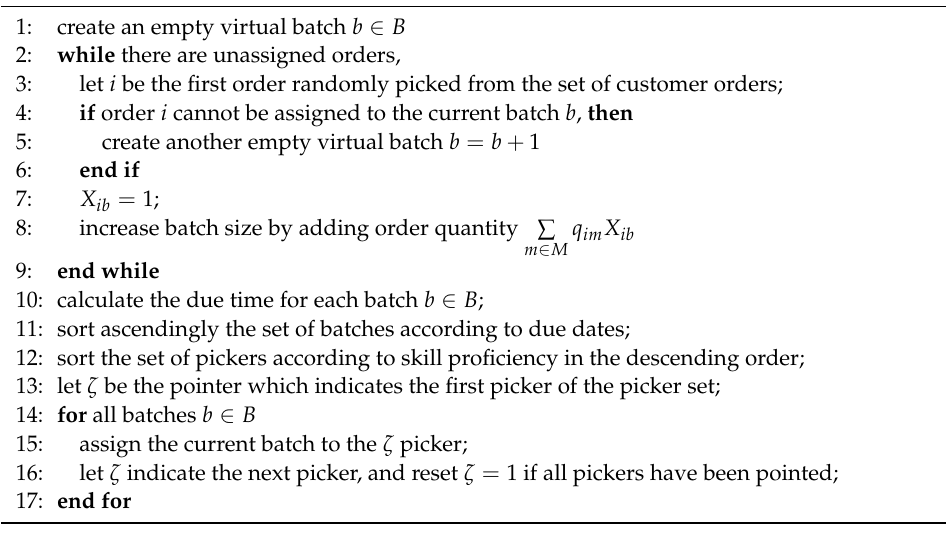
Algorithm 1 Modified Earliest Due Date Policy